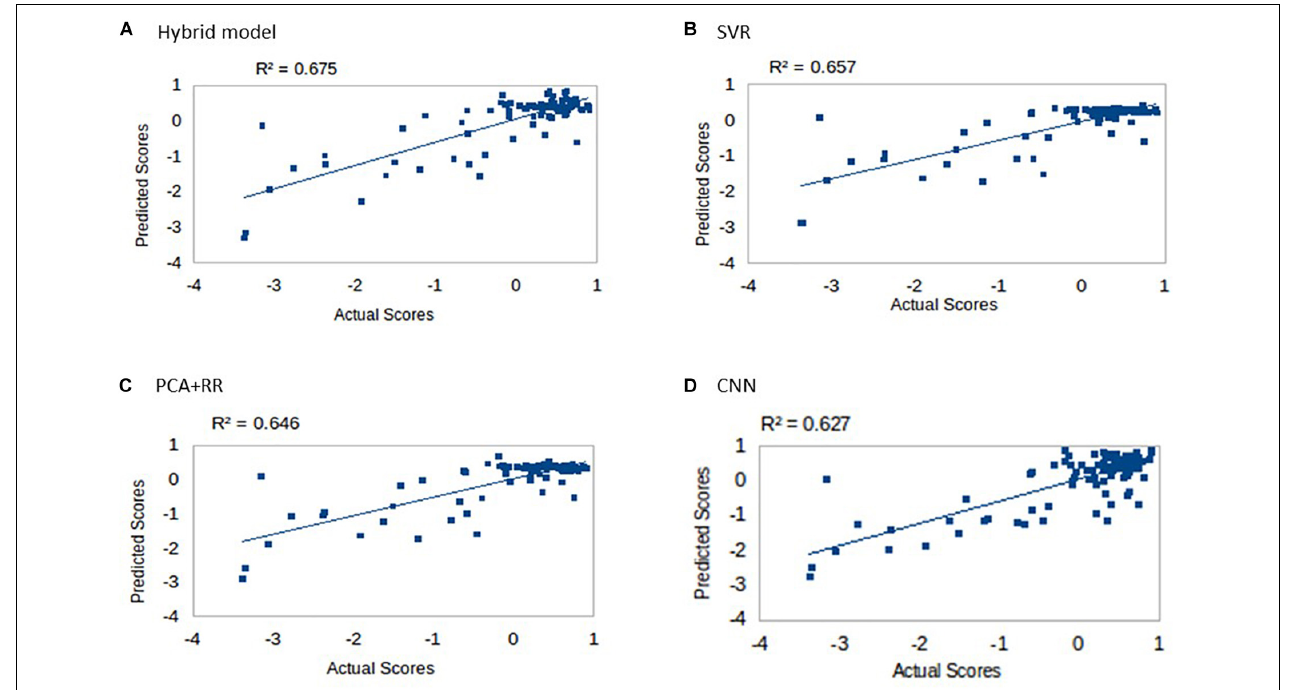
FIGURE 4 | Language scores predicted by the four competing models: (A) Hybrid model, (B) SVR, (C) PCA + RR, and (D) CNN.